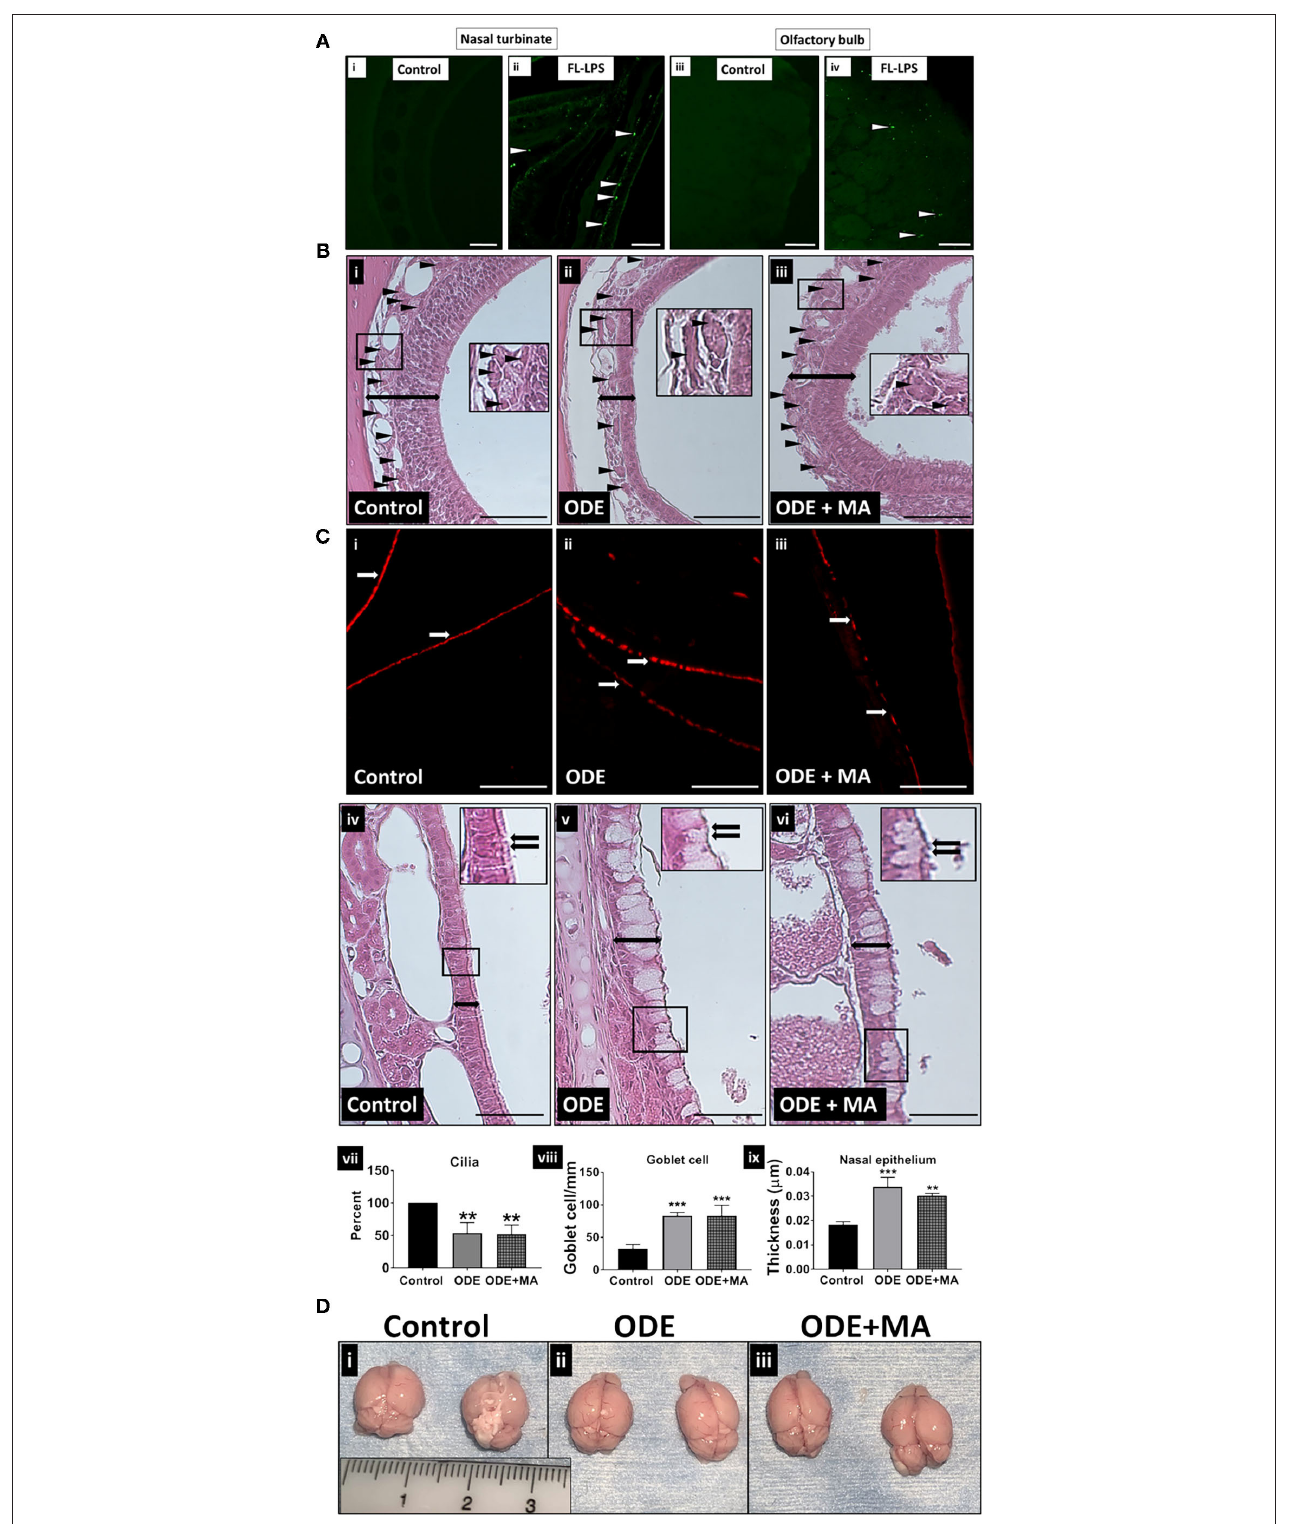
FIGURE 1 | Organic dust extract (ODE) induces gross and histological inflammatory changes in nasal passage and fluorescent lipopolysaccharide (LPS) travel to the olfactory bulb after inhalation. Mice were exposed to various treatments outlined in the Supplementary Table 1 . Paraffin embedded sections from perfused